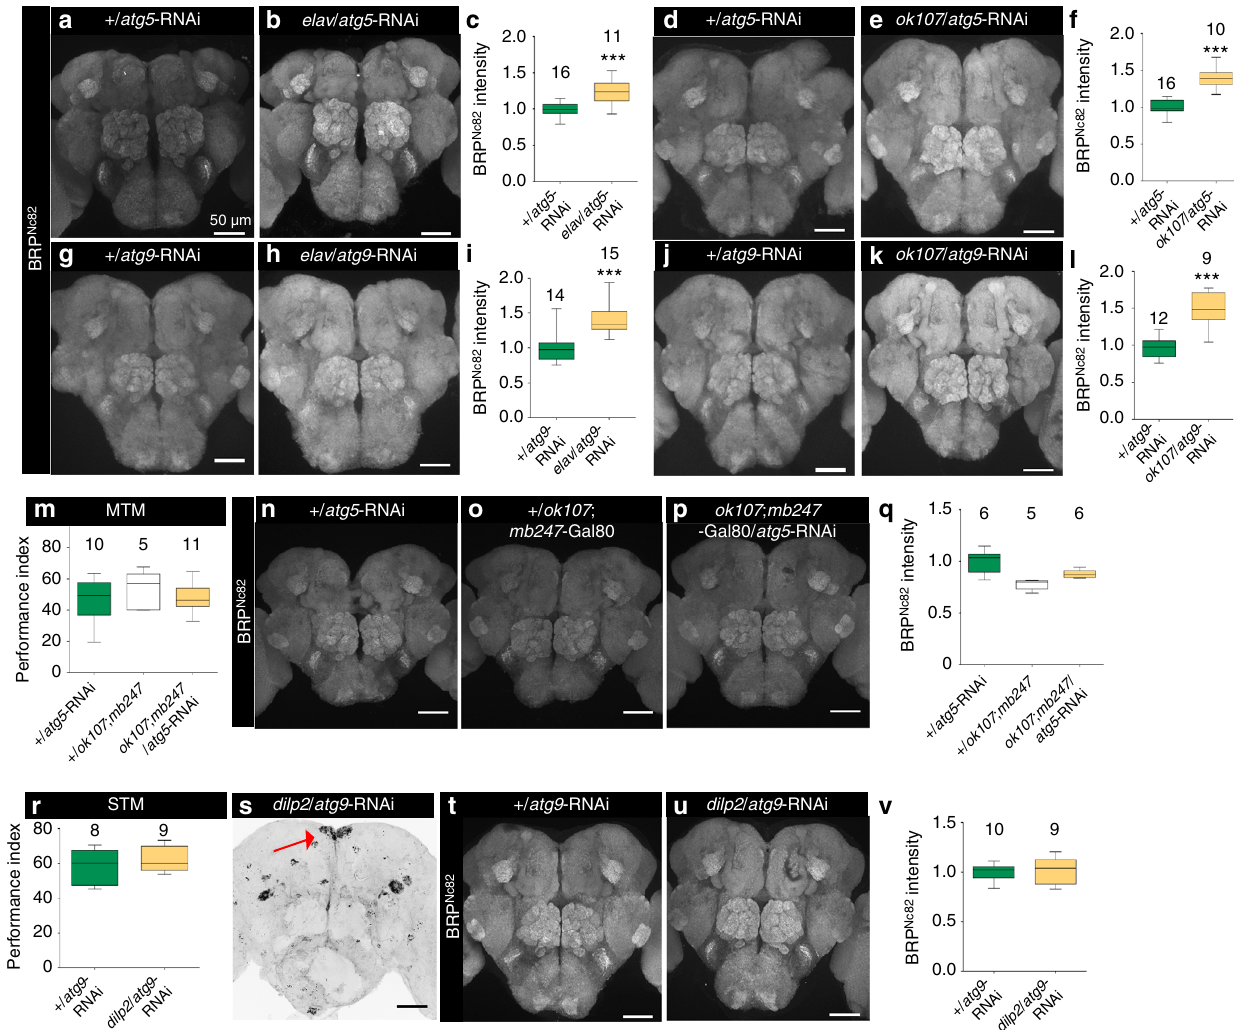
Fig. 3 Mushroom body-speci fi c suppression of autophagy induces brain-wide increase of Bruchpilot. Adult brain, 10 days ( a ) + / atg5 -RNAi and ( b ) elav / atg5 -RNAi immunostained for BRP Nc82 . Scale bar: 50 μ m. c Quanti fi cation of BRP Nc82 intensity within the central brain region normalized to control ( n = 11 – 16 independent brains; *** p < 0.001; Mann – Whitney U -test). Adult brain, 10 days ( d ) + / atg5 -RNAi and ( e ) ok107 / atg5 -RNAi immunostained for BRP Nc82 . Scale bar: 50 μ m. f Quanti fi cation of BRP Nc82 intensity within the central brain region normalized to control ( n = 10 – 16 independent brains; *** p < 0.001; Mann – Whitney U -test). Adult brain, 10 days ( g ) + / atg9 -RNAi and ( h ) elav / atg9 -RNAi immunostained for BRP Nc82 . Scale bar: 50 μ m. i Quanti fi cation of BRP Nc82 intensity within the central brain region normalized to control ( n = 14 – 15 independent brains; *** p < 0.001; Mann – Whitney U - test). Adult brain, 10 days ( j ) + / atg9 -RNAi and ( k ) ok107 / atg9 -RNAi immunostained for BRP Nc82 . Scale bar: 50 μ m. l Quanti fi cation of BRP Nc82 intensity within the central brain region normalized to control ( n = 9 – 12 independent brains; *** p < 0.001; Mann – Whitney U -test). m MTM of + / atg5 -RNAi, + / ok107 ; mb247 -Gal80 and ok107 ; mb247 -Gal80/ atg5 -RNAi ( n = 10 – 15; ns p > 0.5; One-way ANOVA; Kruskal – Walis post-test). Adult brain, 10 days ( n ) + / atg5 -RNAi, ( o ) + / ok107 ; mb247 -Gal80, and ( p ) ok107 ; mb247 -Gal80/ atg5 -RNAi immunostained for BRP Nc82 . Scale bar: 50 μ m. q Quanti fi cation of BRP Nc82 intensity within the central brain region normalized to + / atg5 -RNAi ( n = 5 – 6 independent brains; ns p > 0.5; One-way ANOVA; Kruskal-Walis test). r STM of + / atg9 -RNAi and dilp2 / atg9 -RNAi ( n = 8 – 9; ns p > 0.5; Mann – Whitney U -test). Adult brain, 10 days ( s ) atg9 -RNAi/ + immunostained